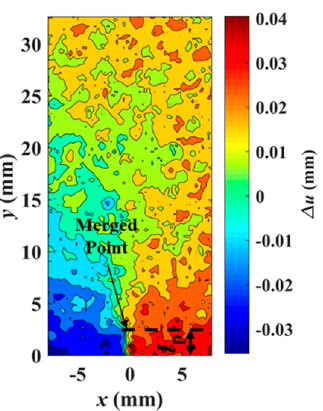
Figure 7. Incremental horizontal displacement contours of water–oil-saturated sample.